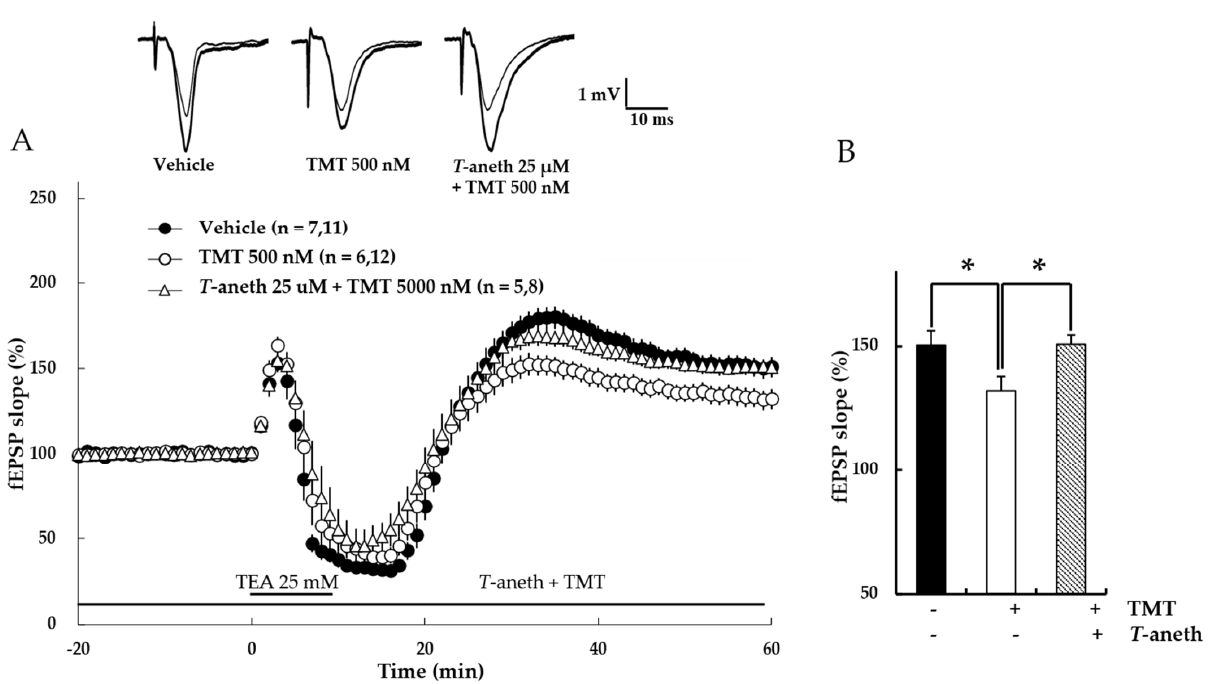
Figure 9. Trans -anethole (25 µ M) modulates the TMT-induced impairment of NMDA receptor- independent LTP. The responses represent LTP induction at 1 h after 1 TBS ( A ). NMDA receptor- independent LTP was induced by TEA. Trans ‐ anethole (25 μ M) was applied 10 min before TMT (500 nM). Each drug was exposed during the time period indicated by the corresponding bar ( B ). Values represent percent changes in the fEPSP slope observed at 58–60 min ( C ). The numbers of mice and slices, respectively, are expressed in parentheses. Filled circles, open circles, and open tri ‐ angles indicate the Vehicle group, 500 nM TMT group, and 25 μ M anethole + 500 nM TMT group, respectively. Statistical significance (* p <0.05 vs. 500 nM TMT) was calculated by one ‐ way ANOVA followed by Tukey HSD test. T ‐ aneth: Trans ‐ anethole; fEPSP: field excitatory synaptic potential.